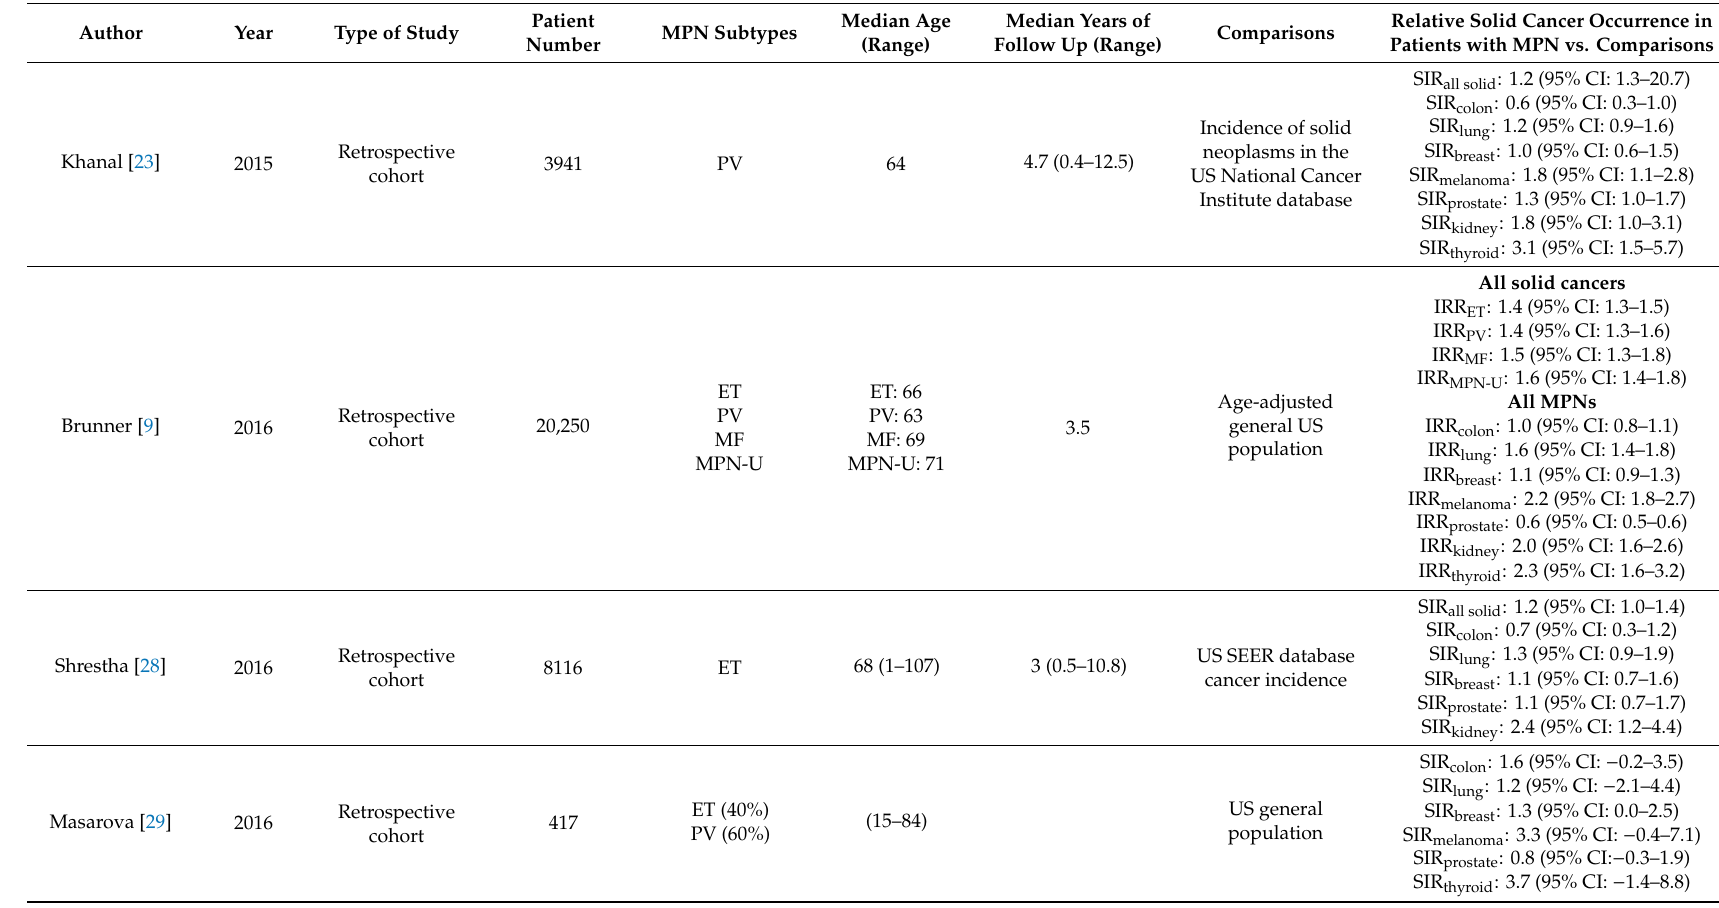
Relative Solid Cancer Occurrence in Comparisons Patients with MPN vs.